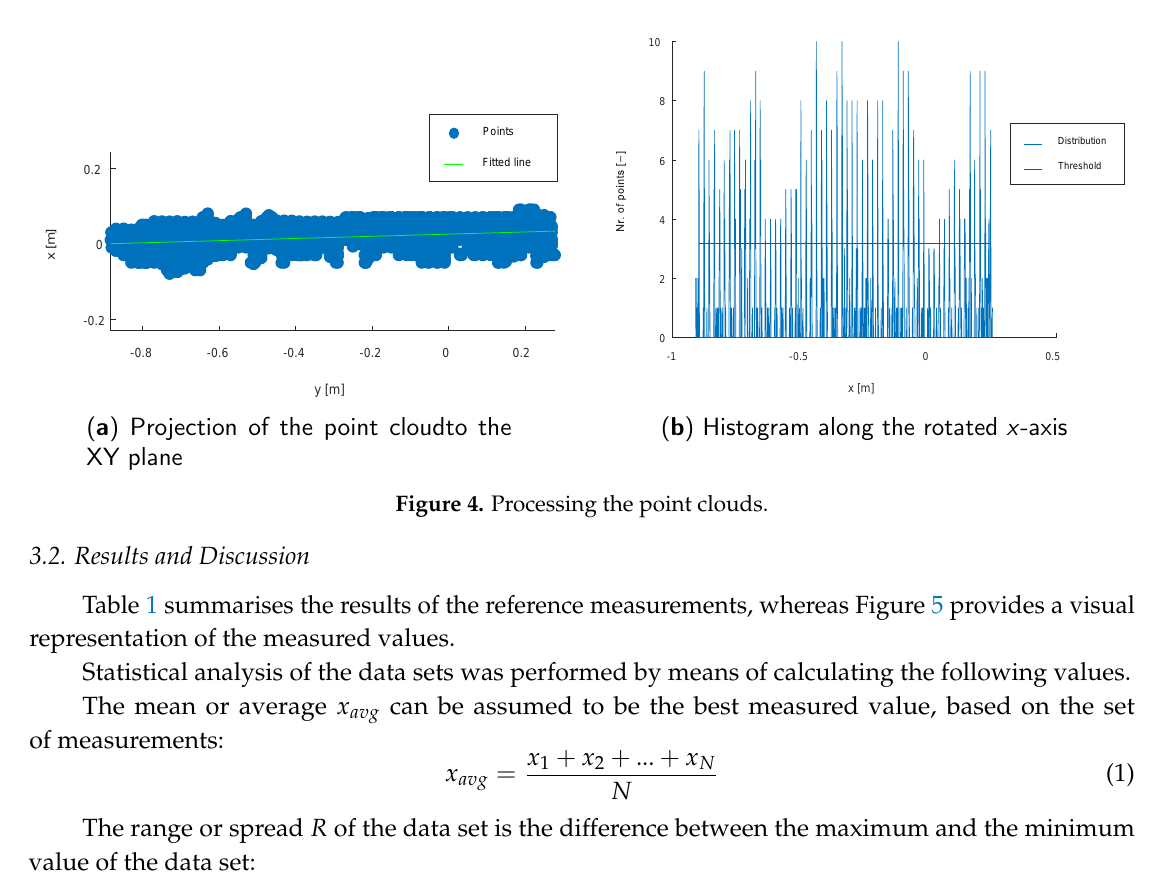
Figure 3. A mesh of the test object scanned with ARCore with the coordinate system.